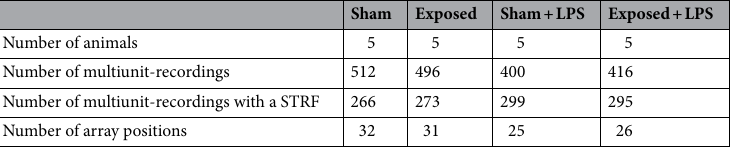
Table 1. Summary of the number of animals and selected cortical recordings in LTE-exposure and LPS- treatment